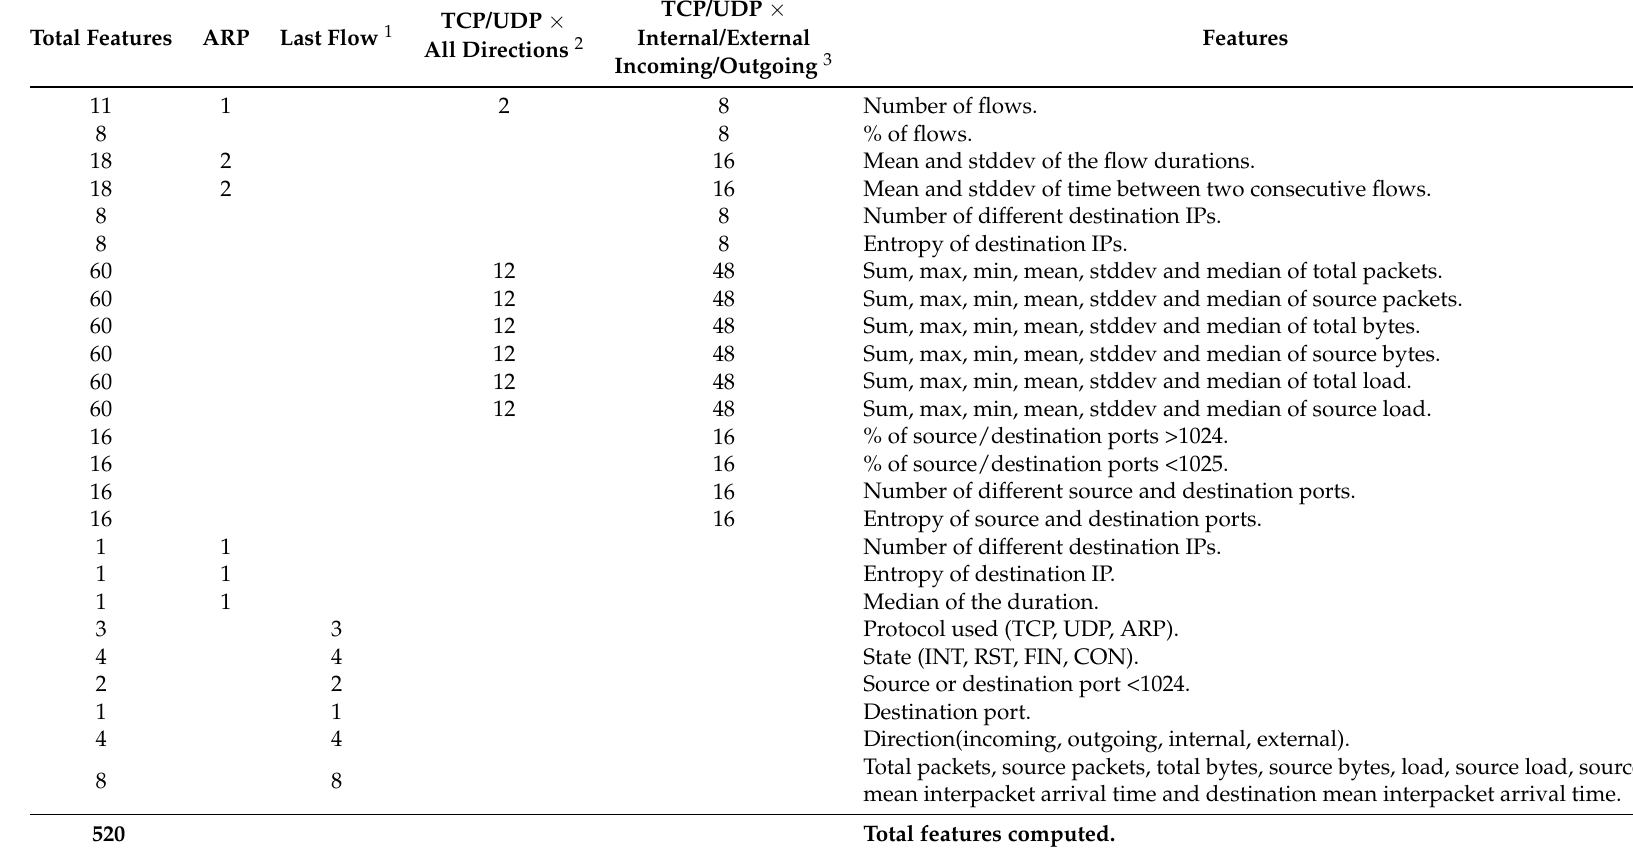
Table 3. TCP/UDP features computed from the network